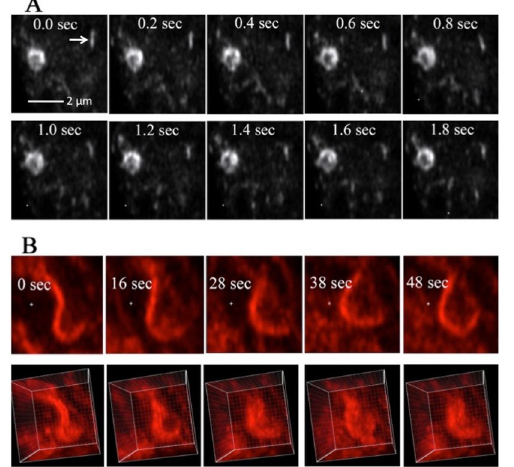
by the PVCs. The position of the dynein within the PVC cavity changed rapidly, with the dynein clumps moving around within the cavity of the PVC. The structure of the dynein and its association with the PVCs was visualized at high resolu- tion with the Zeiss/Airyscan (Fig 5). Most of the dynein, presumed to be bound to microtu- bules, had a linear shape, parallel to the long axis of the hypha. The dynein observed in clumps was inside the cavities of PVCs. Dynein did not completely fill the cavity of the PVCs (Figs 4 and 5 and S6 Movie).